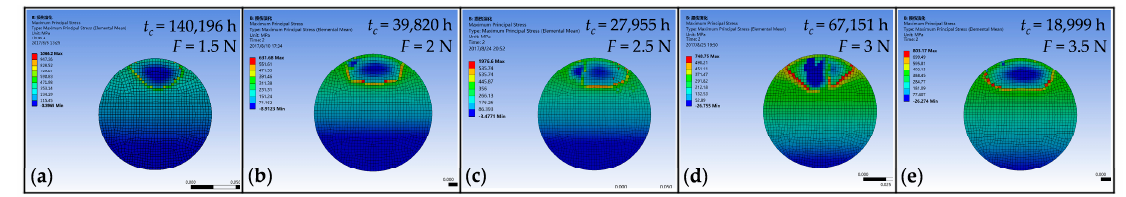
Figure 8. The maximum principal stress maps and crack shapes for five loads ( F = 1.5, 2, 2.5, 3, 3.5 N) at 18,999 h.